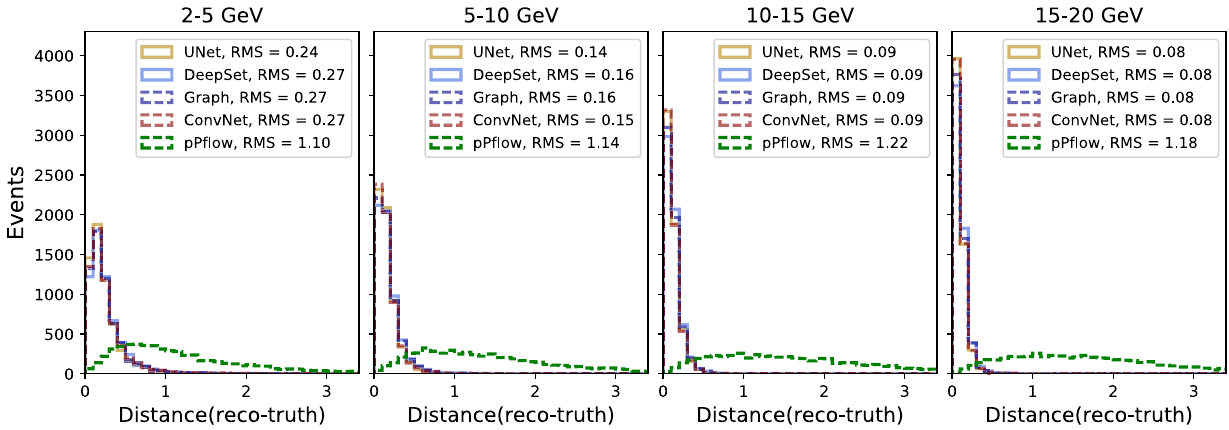
Fig. 6 The distance computed in number of cells between the barycenter of the predicted and truth neutral energy in the ECAL2 layer when using the pPflow or the NN algorithms for different energy ranges described in the text. The equivalent distributions in different calorimeter layers show a similar